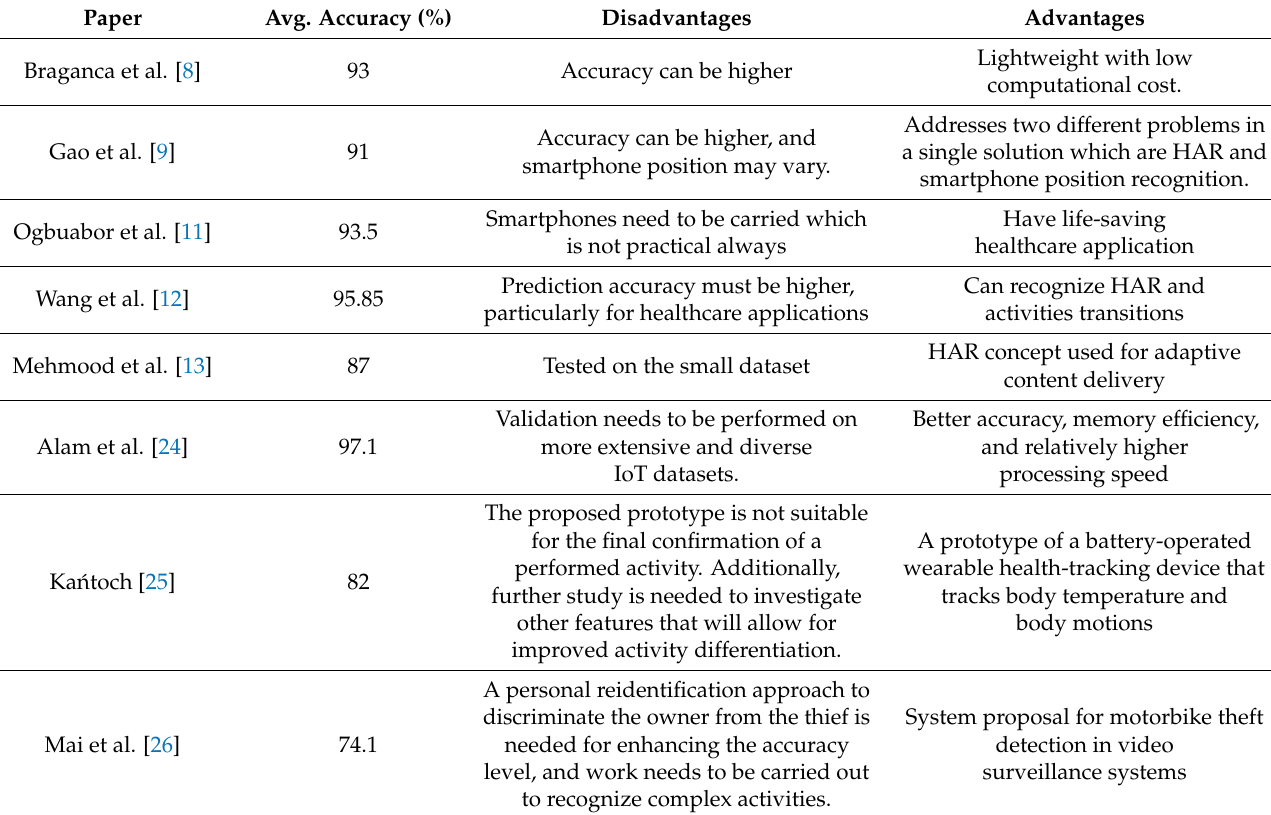
Table 1. A Comparison of the Related